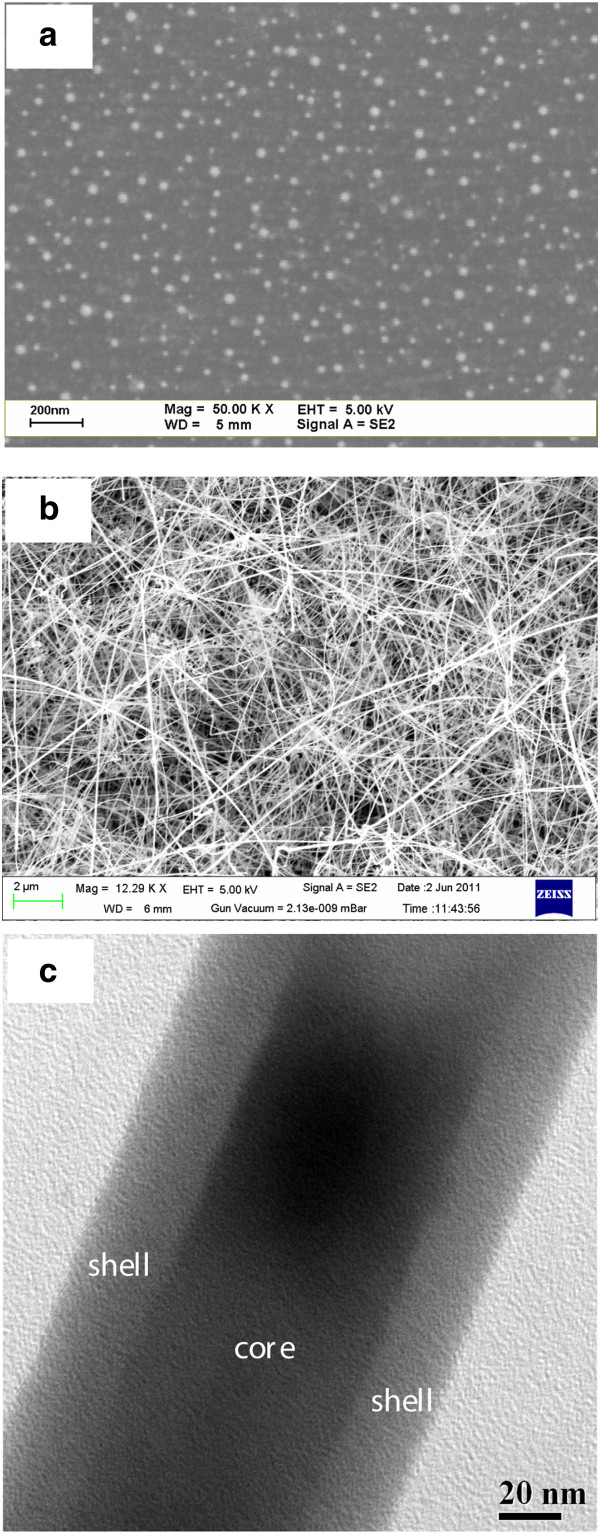
SEM and TEM images. SEM images of (a) Au nanoparticles and (b) Ge NWs on Si substrates. (c) TEM image of core-shell Ge/GeOx NWs.